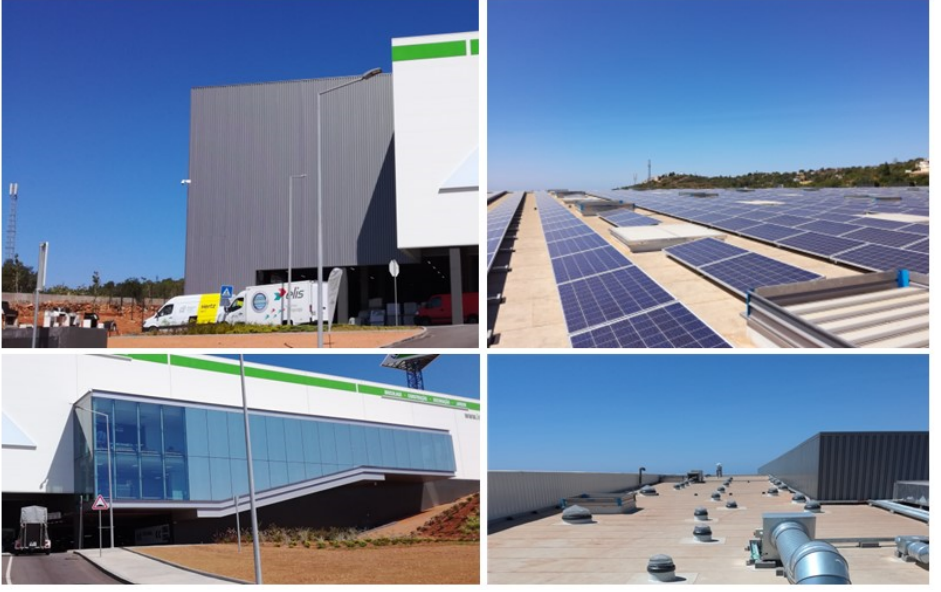
Figure 2. Front facade and roof with photovoltaic panels of the case study store in Algarve, Portugal.